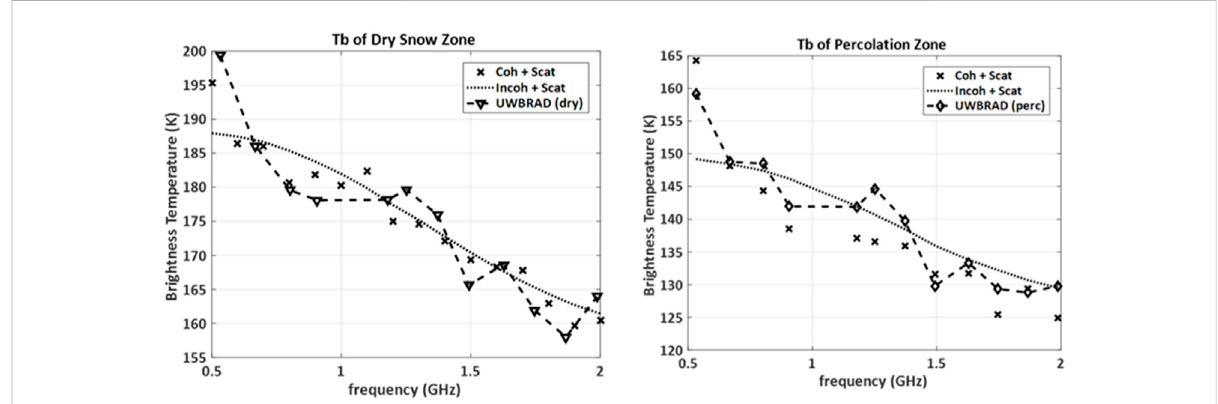
FIGURE 5 Coherent and incoherent T B models for the Greenland dry snow zone along with wide band data (left). The same models for the percolation zone and UWBRAD data on the right. The coherent model better captures some of the fl uctuations in the wide band data and also the increase in T B at the lowest frequencies (From Jezek et al.,